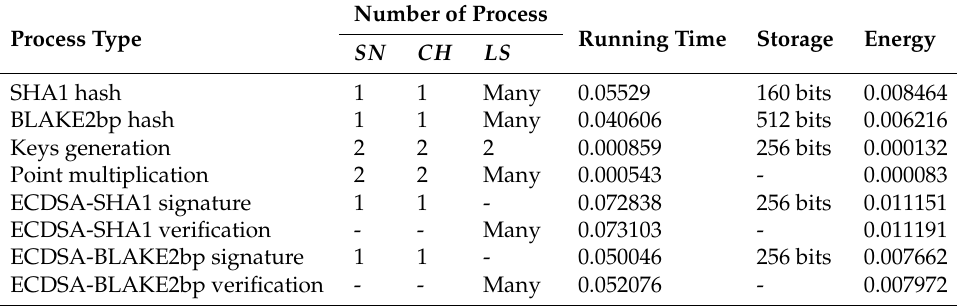
Table 5. REISCH’s computational